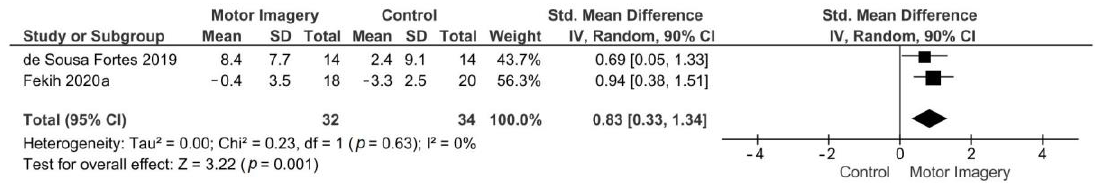
Figure 5. Effect of motor imagery on tennis stroke velocity versus watching videos as control intervention.